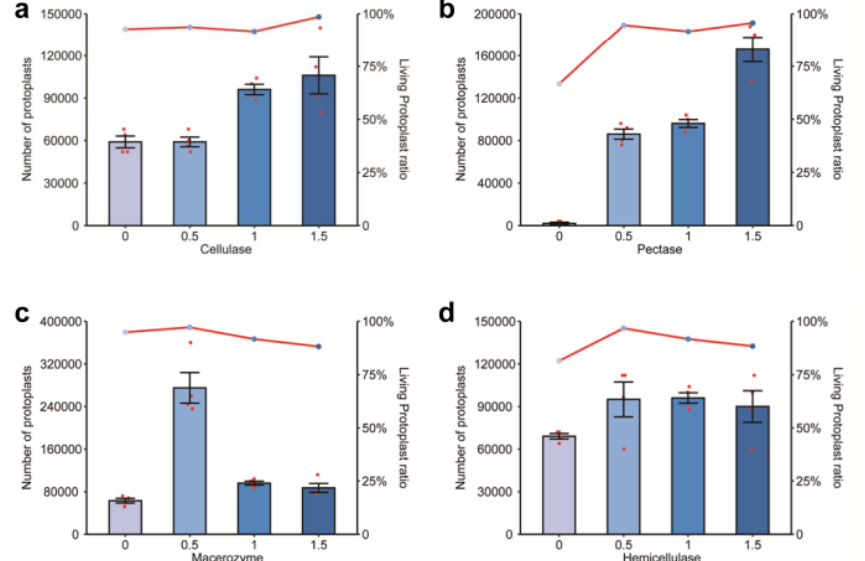
Figure 2. Microscopic examination of protoplasts extracted with solutions containing different concentrations of enzymes. Comparisons of protoplasts extracted with solutions containing different concentrations of ( a ) cellulase, ( b ) pectinase, ( c ) macerozyme, and ( d ) hemicellulase. Scale bars = 100 µ m.